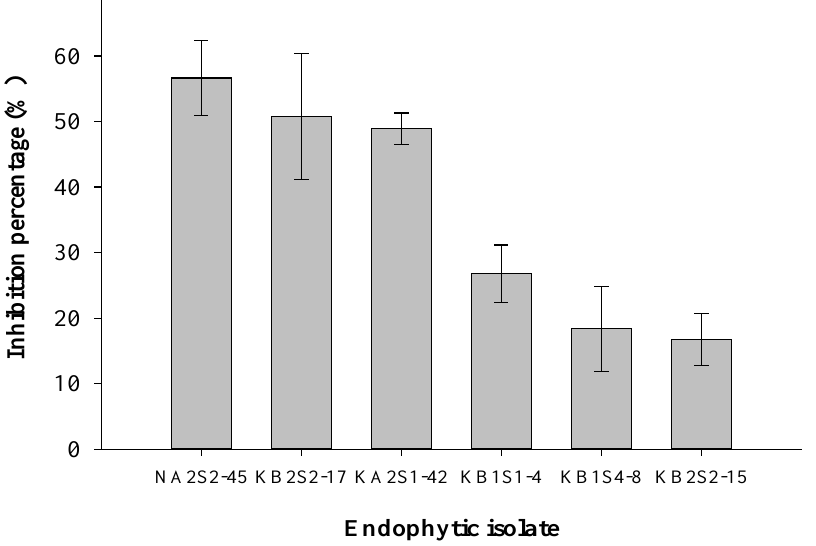
Figure 5. Suppressive effects (%) of the VOCs secreted by the endophytic fungi against mycelial growth of P. infestans . Error bars represent the standard error of means (n = 8).